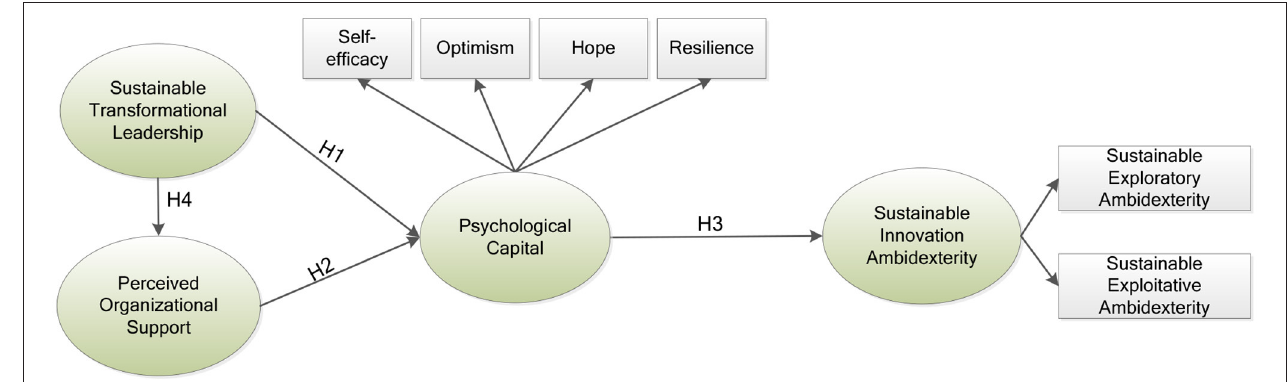
FIGURE 1 | Theoretical